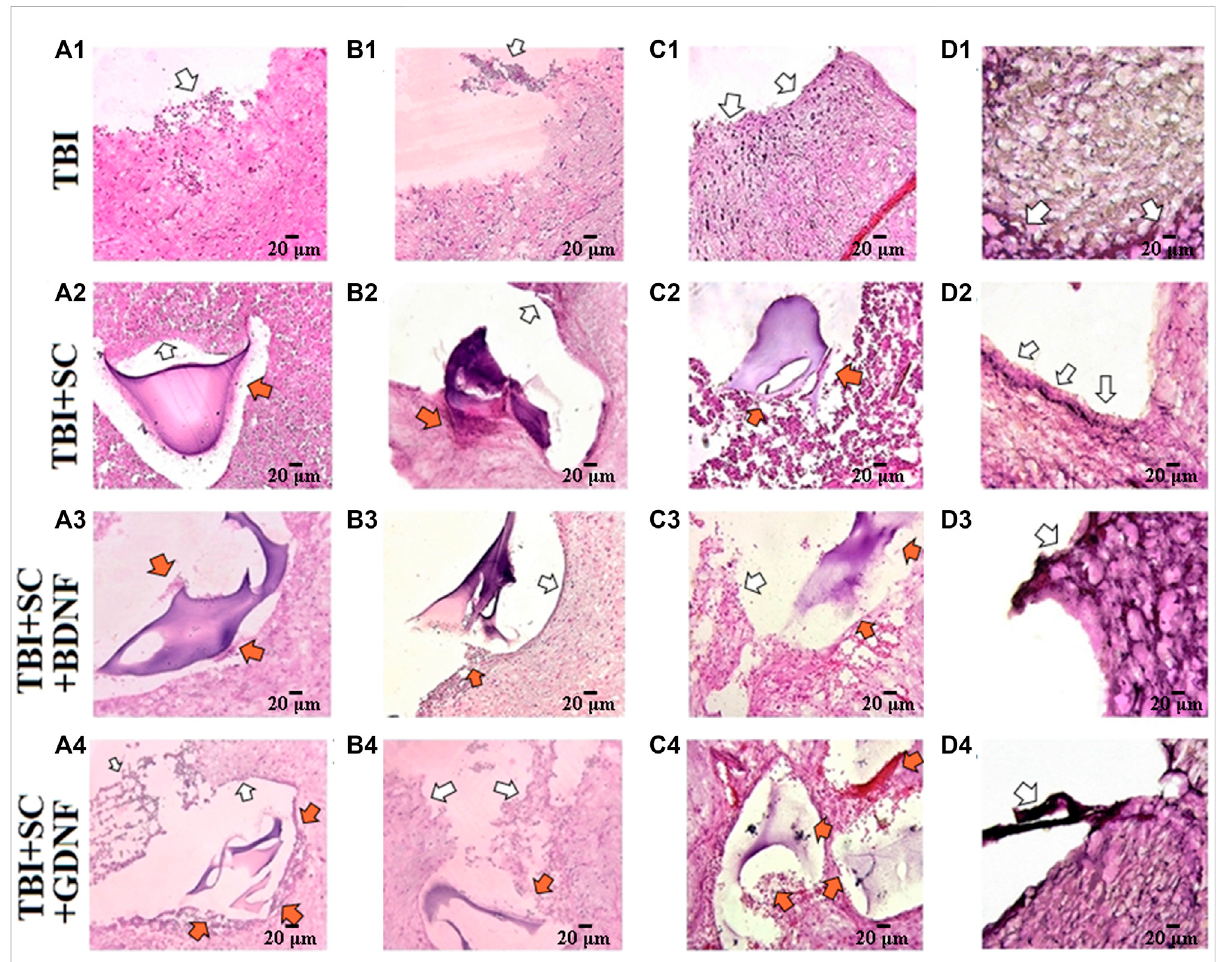
FIGURE 8 Representative histological samples of brain cortex of mice after traumatic brain injury and scaffolds implantation. Hematoxylin-eosin staining, magni fi cation ×20. A1-A4: 7 days after implantation, B1-B4: 21 days after implantation; C1-C4: 2 months after implantation; D1-D4: 6 months after implantation. White arrows indicate the sites of nerve tissue expansion and signs of in fl ammation. Orange arrows indicate the sites of neuronal process outgrowth toward the scaffold Scale bars, 20 μ